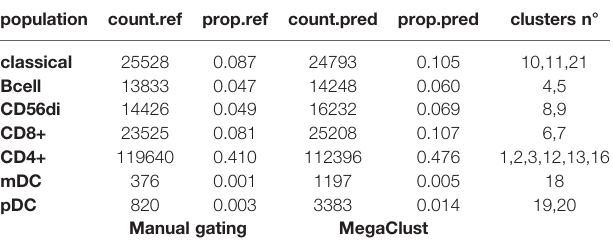
TABLE 1B | Table of detected cell numbers and clusters in comparison to MG populations. population count.ref prop.ref count.pred prop.pred